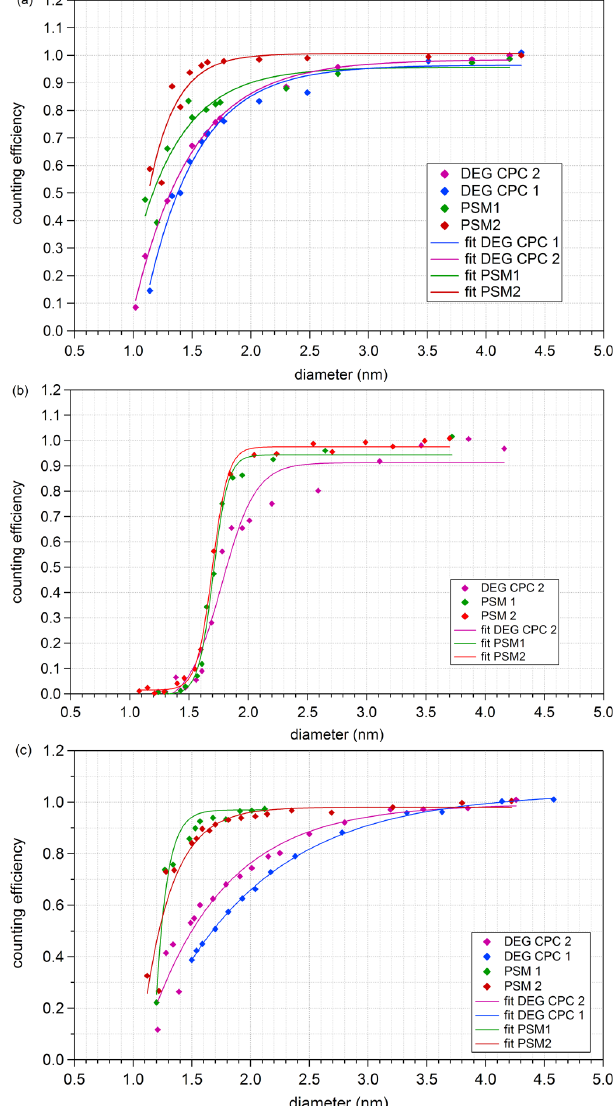
Fig. 7. Detection efficiencies for the DEG CPCs compared to the PSMs using negatively charged ammonium sulfate (a) , positively charged ammonium sulfate (b) and negatively charged sodium chlo- ride particles (c) produced in the closed loop high-resolution